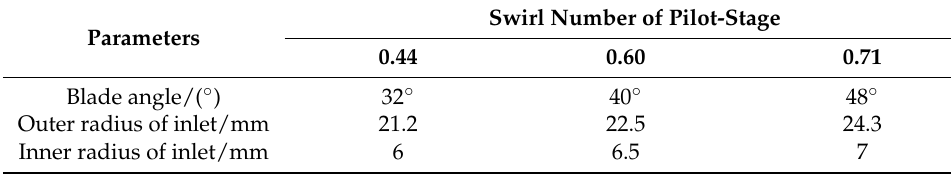
Table 1. Parameters of the three different